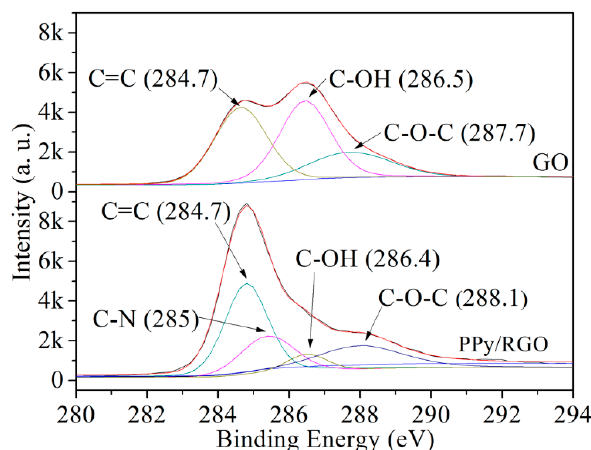
Figure 6. De-convoluted ESCA energy spectrum for GO and PPy/RGO.